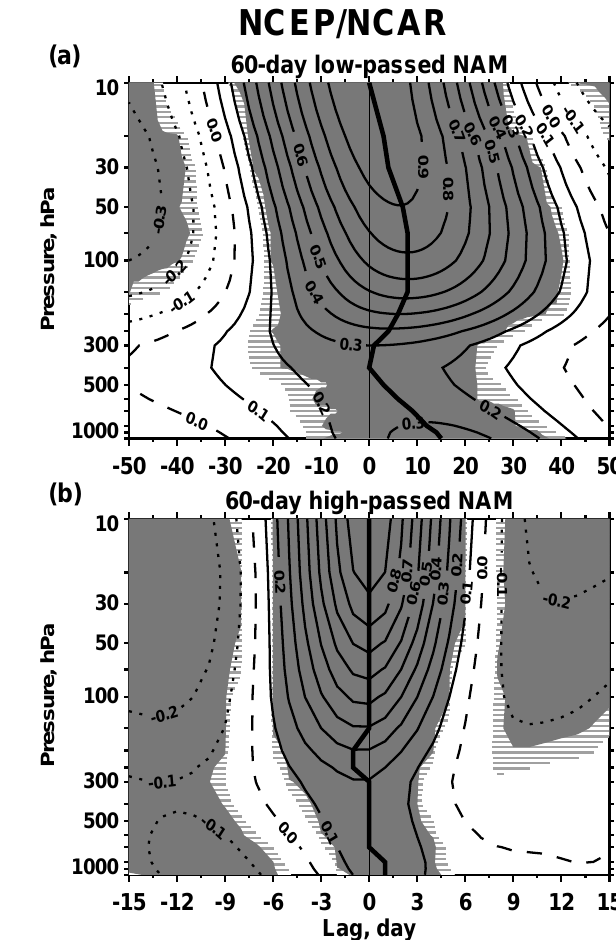
Fig. 1. Cross-spectral analysis between the NAM index at 10hPa and 70hPa. Dashed and thin solid lines are the 95% and 99% con- fidence levels, respectively. The NCEP-NCAR reanalysis.